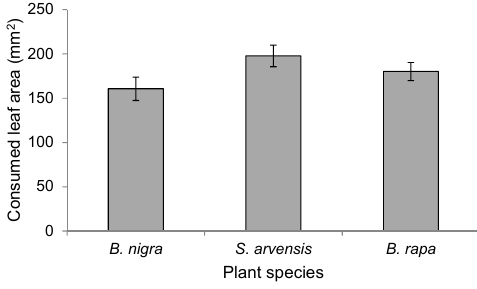
Figure 5. Leaf area consumed by 20 first instar Pieris brassicae feeding for 24 h on either Brassica rapa , Sinapis arvensis , or Brassica nigra plants. Bars present the means ± SE ( n = 19).